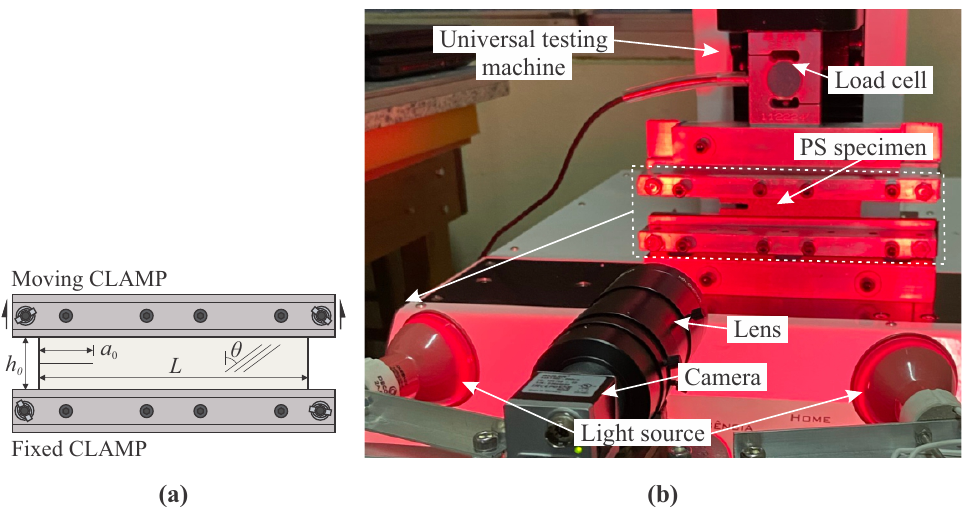
Figure 2. ( a ) Schematic representation of the PS specimen with a pre-crack of a 0 = 20 mm and ( b ) experimental